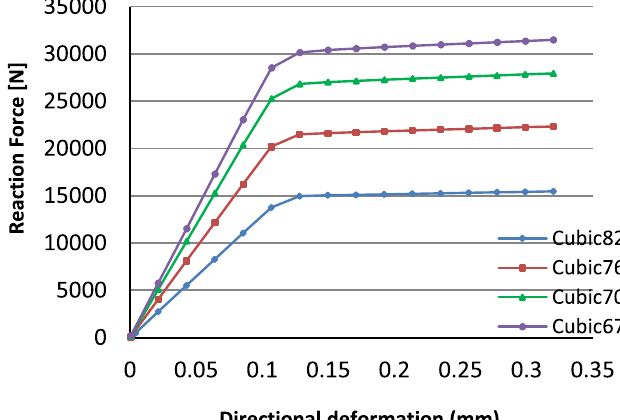
Fig. 5. Reaction force (cid:3) directional deformation curves of the Cubic porous structures with four